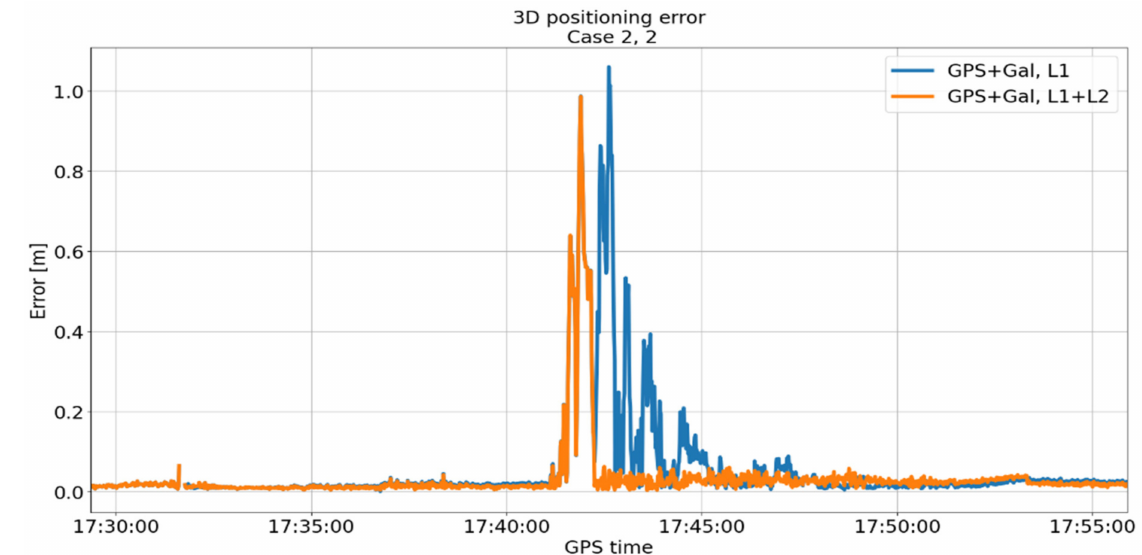
Figure 16. 3D positioning error for a single- and a dual-frequency GPS + Galileo solution for Case 2, baseline 2 (11 km). Only the solution of the first part of the jamming incident is